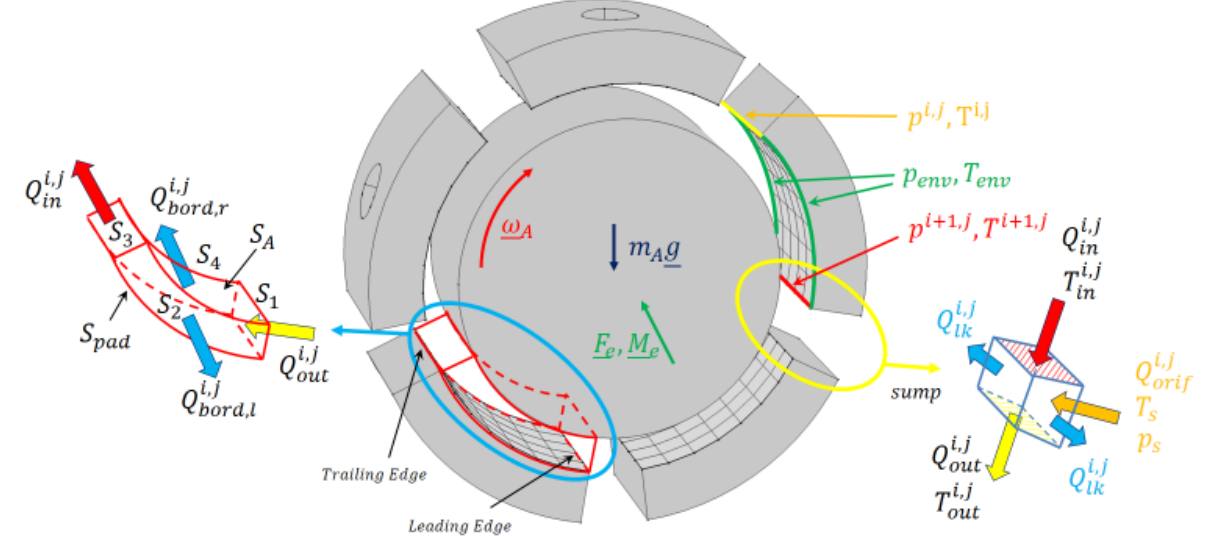
Figure 6. TPJB structure, lubricant supply plant and control